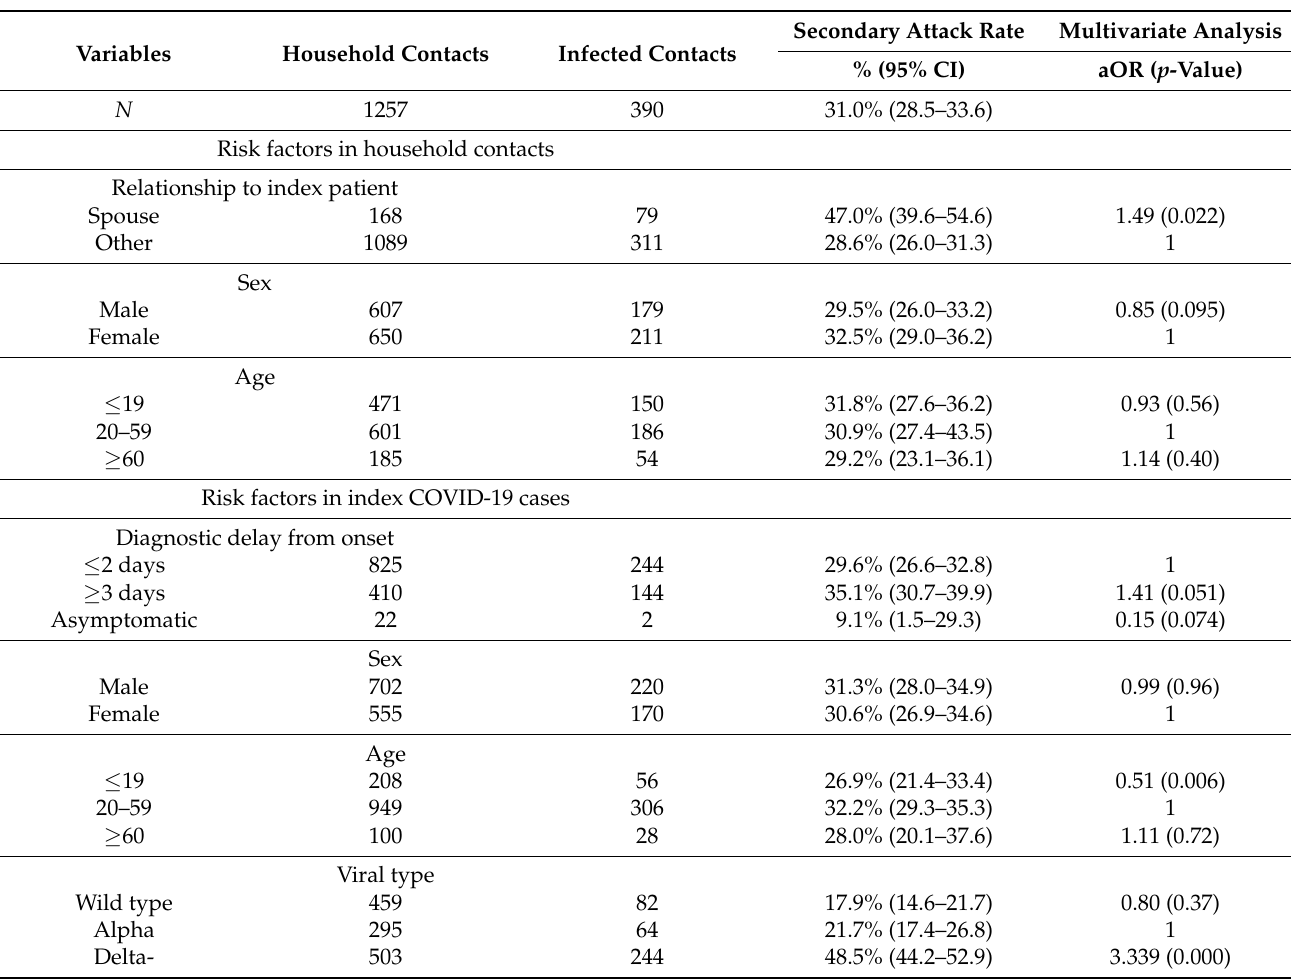
Table 3. Secondary attack rate among unvaccinated household contacts of COVID-19 patients by